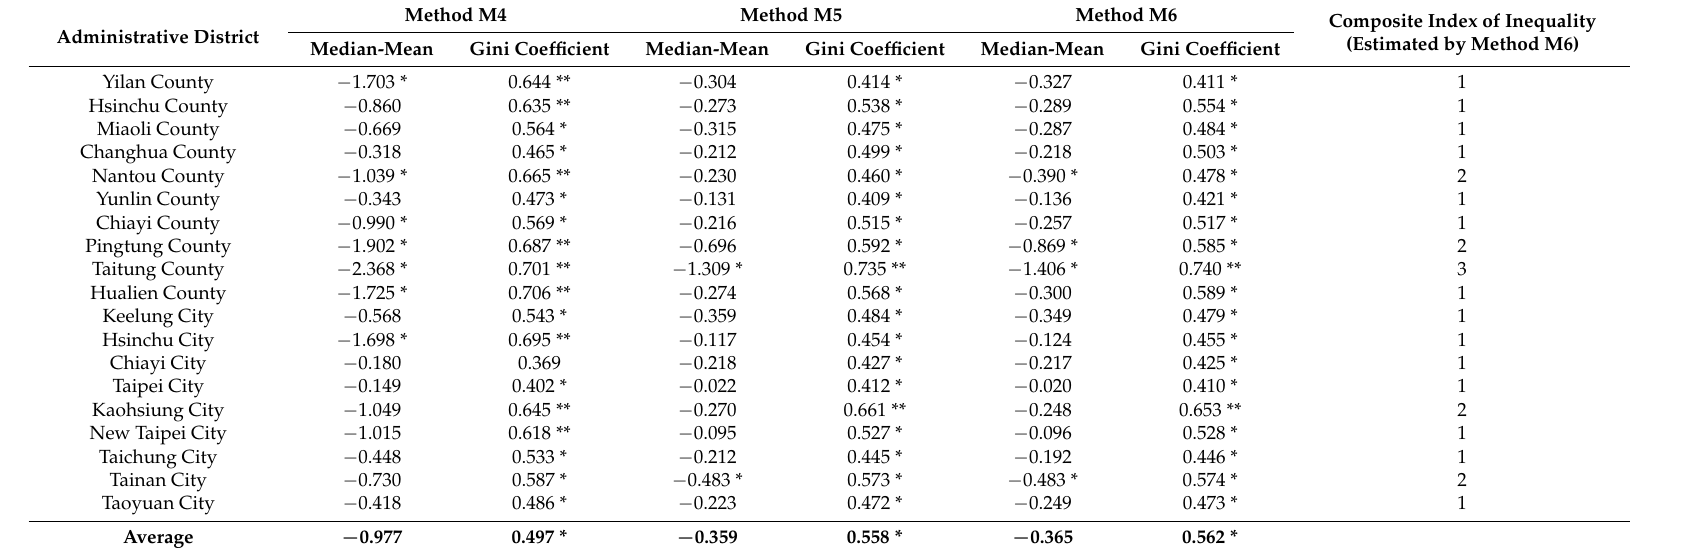
Table 10. Measures of spatial inequality of community care resources using methods